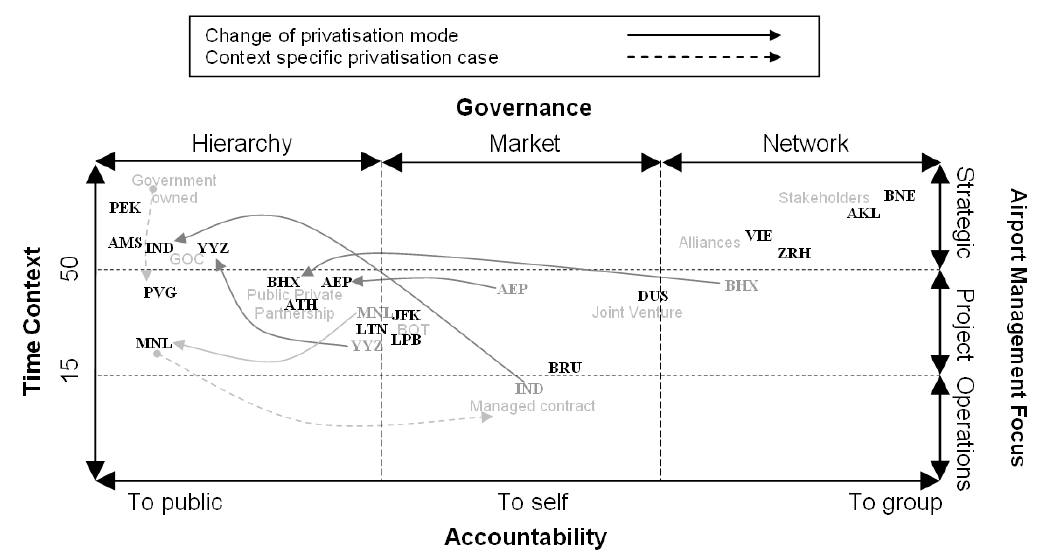
Figure 2. Study airports’ focus, governance and